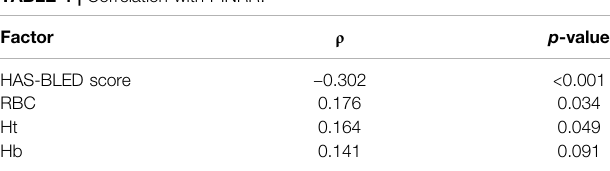
TABLE 4 | Correlation with